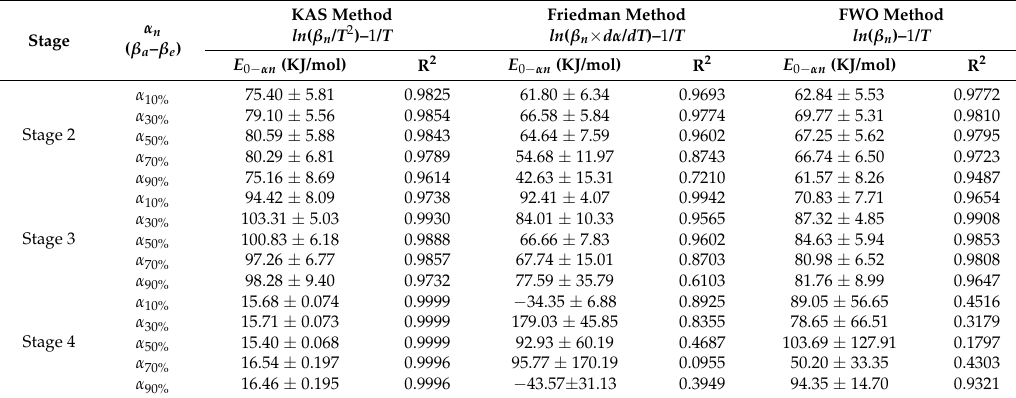
Table 8. The activation energies of stages two, three, and four obtained from the KAS, FWO, and Friedman